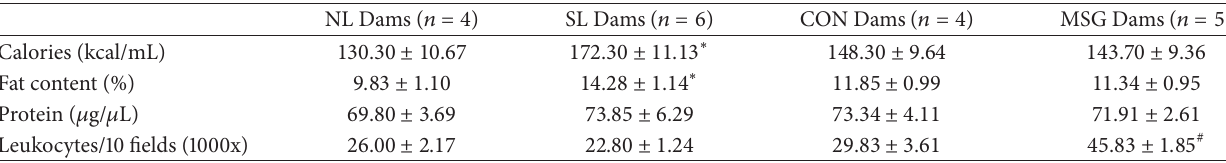
Table 2: Milk composition in lactating dams at 21 days of lactation.